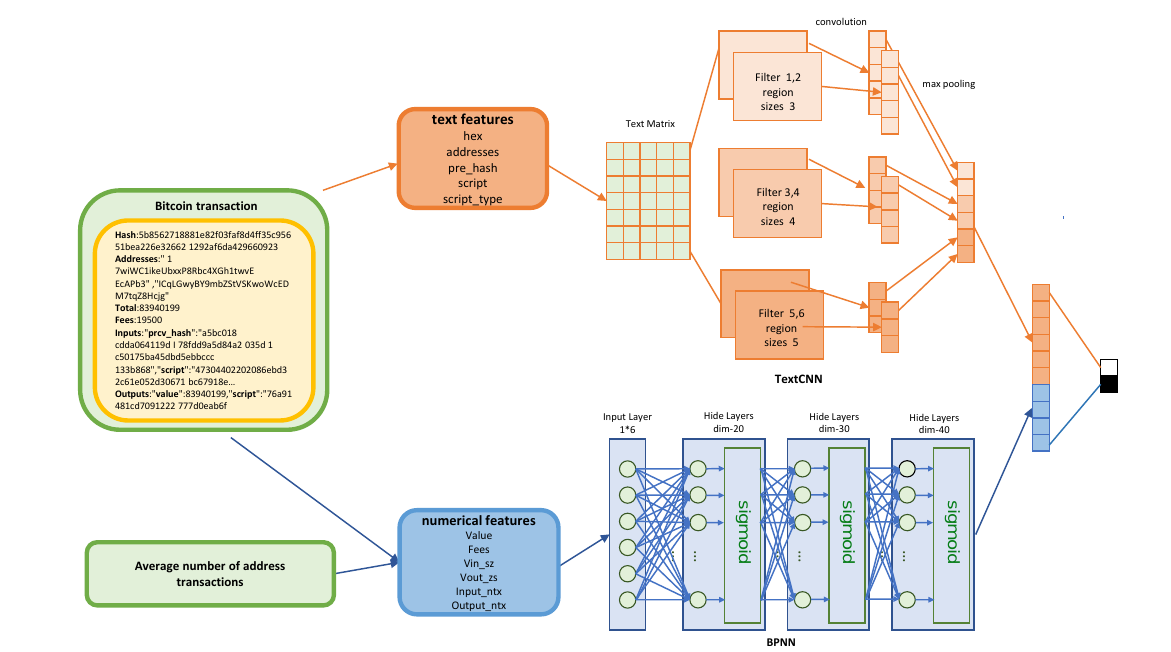
Figure 4. Architecture of the CTR [6]